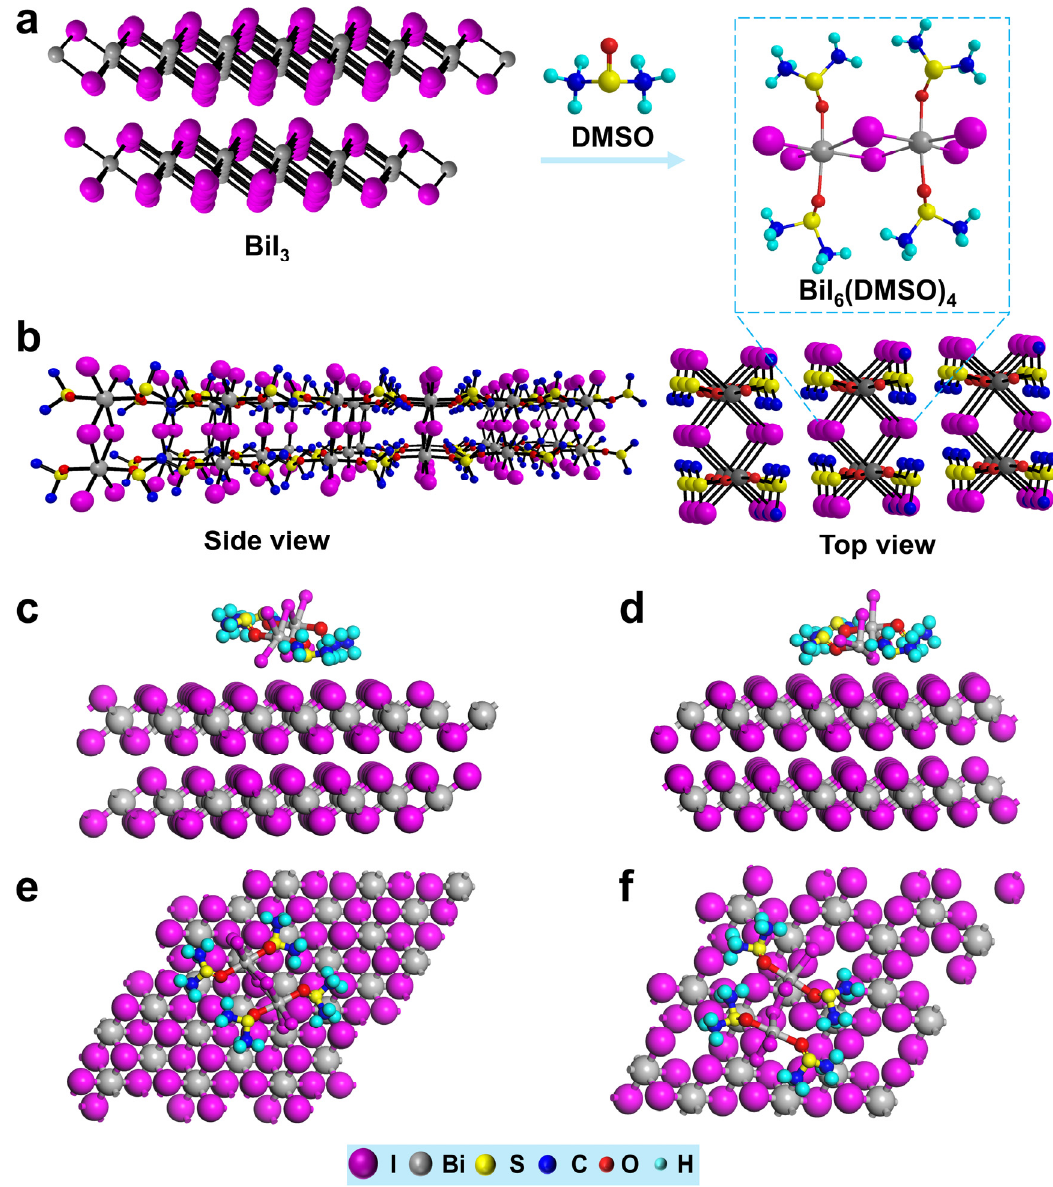
Figure 1. ( a ) Schematic diagram on the formation process and ( b ) crystal structure of BiI 3 (DMSO) 2 . The boxed fragment Bi 2 I 6 (DMSO) 4 has a space group P1 with dimensional parameters a = 8.3303(6) Å, b = 8.8638(6) Å, c = 12.4967(8) Å, α = 92.275(5)°, β = 101.467(6)°, γ = 117.263(7)°. DFT calculations. ( c ) The front view and ( e ) the top view of BiI 3 (DMSO) 2 complex absorbs on the BiI 3 surfaces. ( d ) The front view and ( f ) the top view of BiI 3 (DMSO) 2 complex adsorbs on the defective BiI 3 surface containing iodide vacancies.